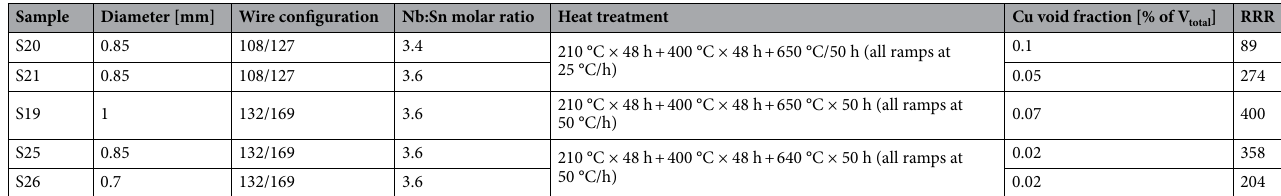
Table 1. Summary of samples characteristics, Residual Resistivity Ratio (RRR) and Cu void